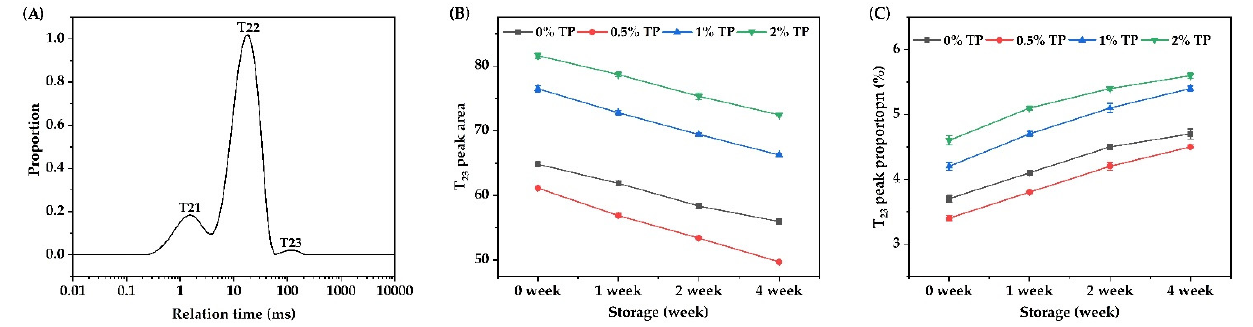
Figure 7. The LF-NMR spin relaxation (T 2 ) test of NFFD during storage. ( A ) A typical T 2 relaxation distribution curve, ( B ) peak area of T 23 , and ( C ) peak area proportions of T 23 .